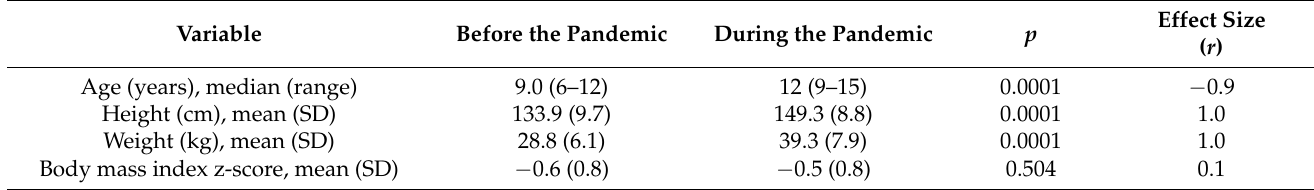
Table 1. Participants’ demographic characteristics before and during the COVID-19 pandemic ( N = 40; 23 girls and 17